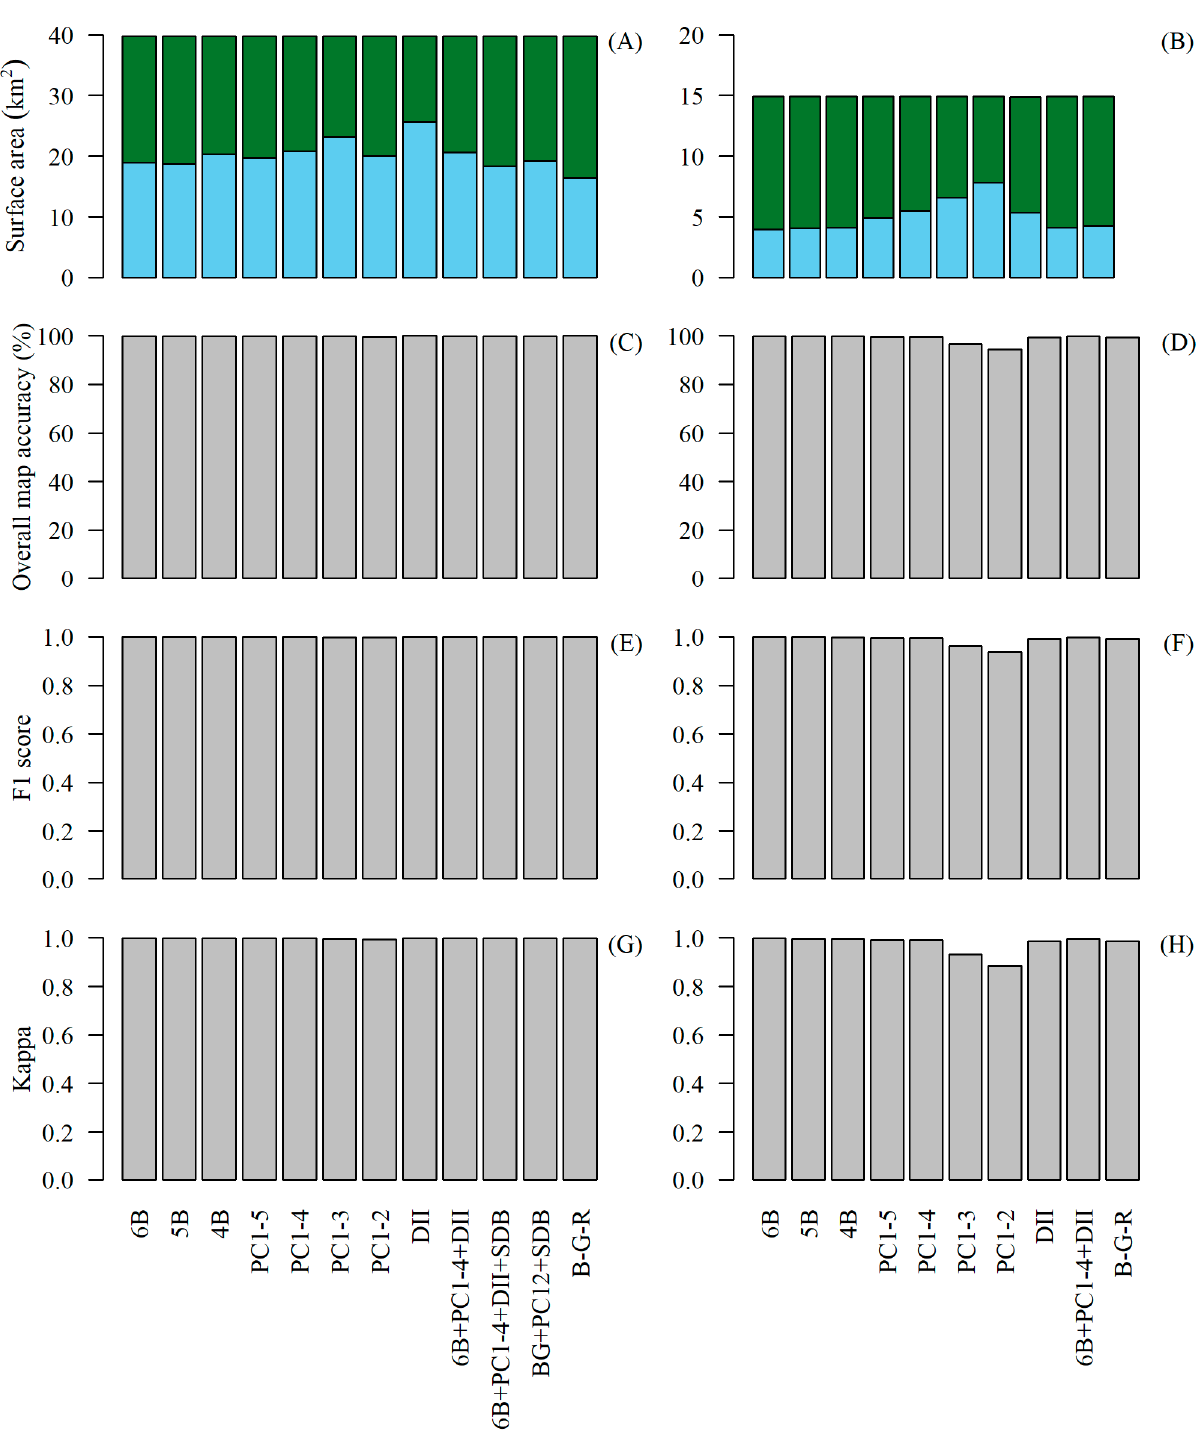
Figure 4. Average metrics of surface area (km 2 ; A , B ), overall map accuracy (%; C , D ), F1 score ( E , F ) and Kappa ( G , H ) for the 11 August (left column) and 17 August (right column) WorldView-3 bottom habitat maps built using 12 different combinations of input parameters of spectral bands (6B/5B/4B), principal components (PC), depth invariant indices (DII), and satellite derived bathymetry (SDB). The coastal blue to red-edge bands were used for 6B, coastal blue to red for 5B, and coastal blue to yellow for 4B. B-G-R is a classification built on only the blue, green, and red spectral bands, identical to the Sentinel-2 bottom habitat classification. Vegetated habitat surface area is denoted with green and bare with blue.